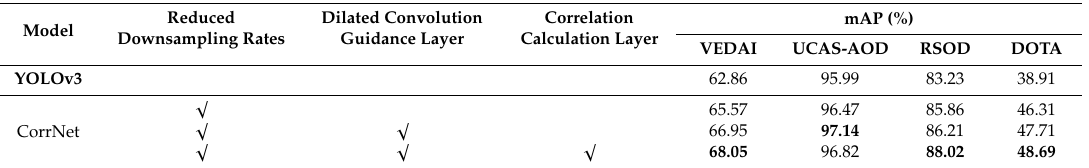
Table 5. E ff ectiveness of di ff erent optimization methods in each dataset (The best results are marked in bold).